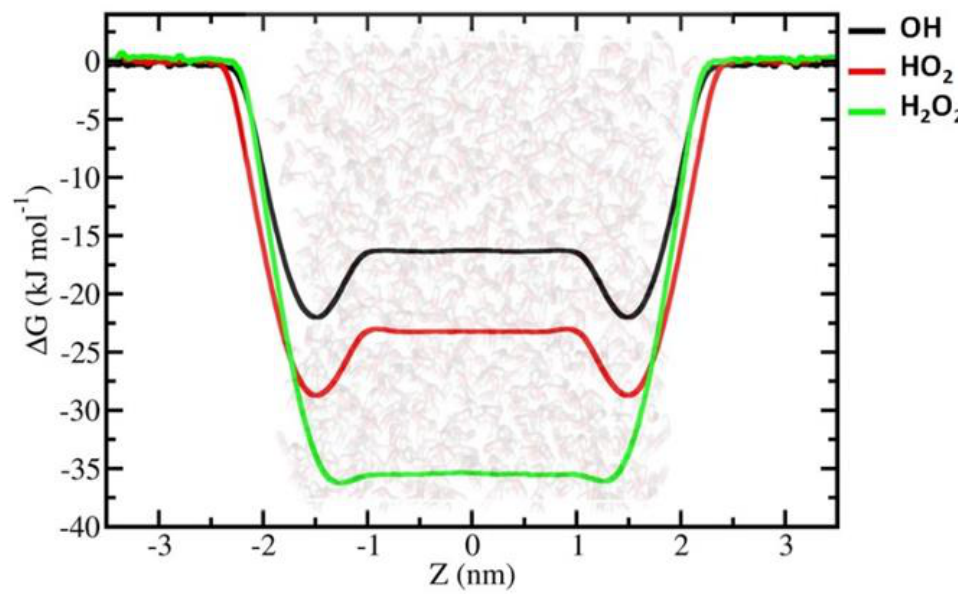
Figure 2. FEPs of the hydrophilic ROS obtained by US simulations by calculation of the WHAM method. Table 1. Free energy p values with ∆ G hydr were calculated from experimental Henry’s law constants and concentration enhancement of species at the vacuum–water interface and in the water bulk.